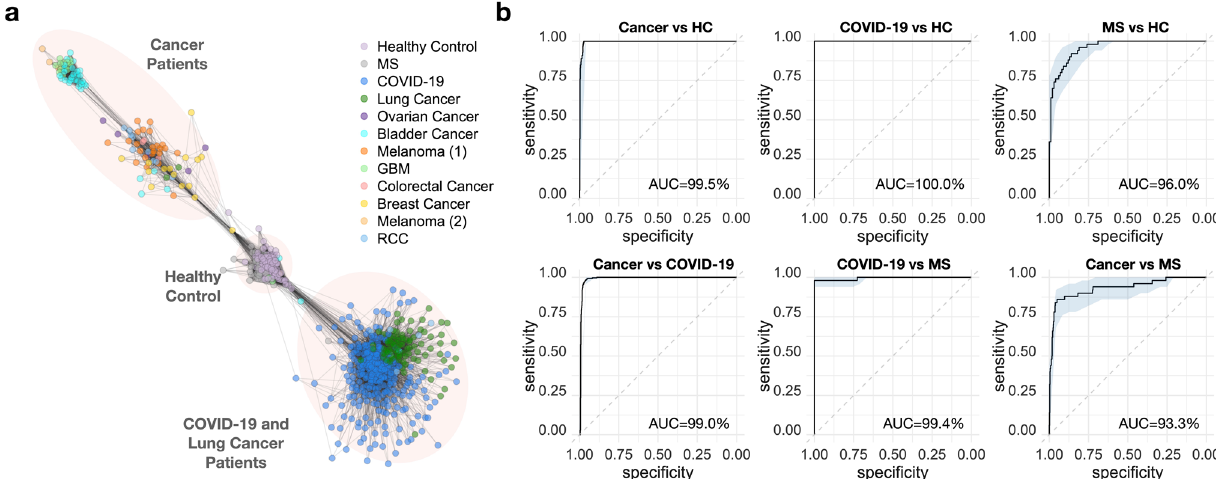
Fig. 4 Disease-speci fi c grouping of TCR repertoire samples via ultra-large-scale clustering. a Graphic representation for the similarities of the TCR-seq samples based on TCR co-clustering. Sample-wise count-sharing matrix was computed from the original TCR clustering results of the 1,213 reference samples. Spearman correlation matrix was calculated based on counts of co-clustered TCRs, with pairs having a correlation value ≤ 0.4 set to be zero. The resulting sparse matrix was used to generate the graph. Nodes with fewer than two connections were removed to visualize the sample groups. b ROC curves using disease fractions calculated from co-clustered TCRs. AUC values were labeled at the bottom right of each panel. 95% con fi dence intervals were calculated using 2,000 strati fi ed bootstraps. Disease abbreviations: GBM for glioblastoma multiforme; RCC for renal clear cell carcinoma; MS for multiple